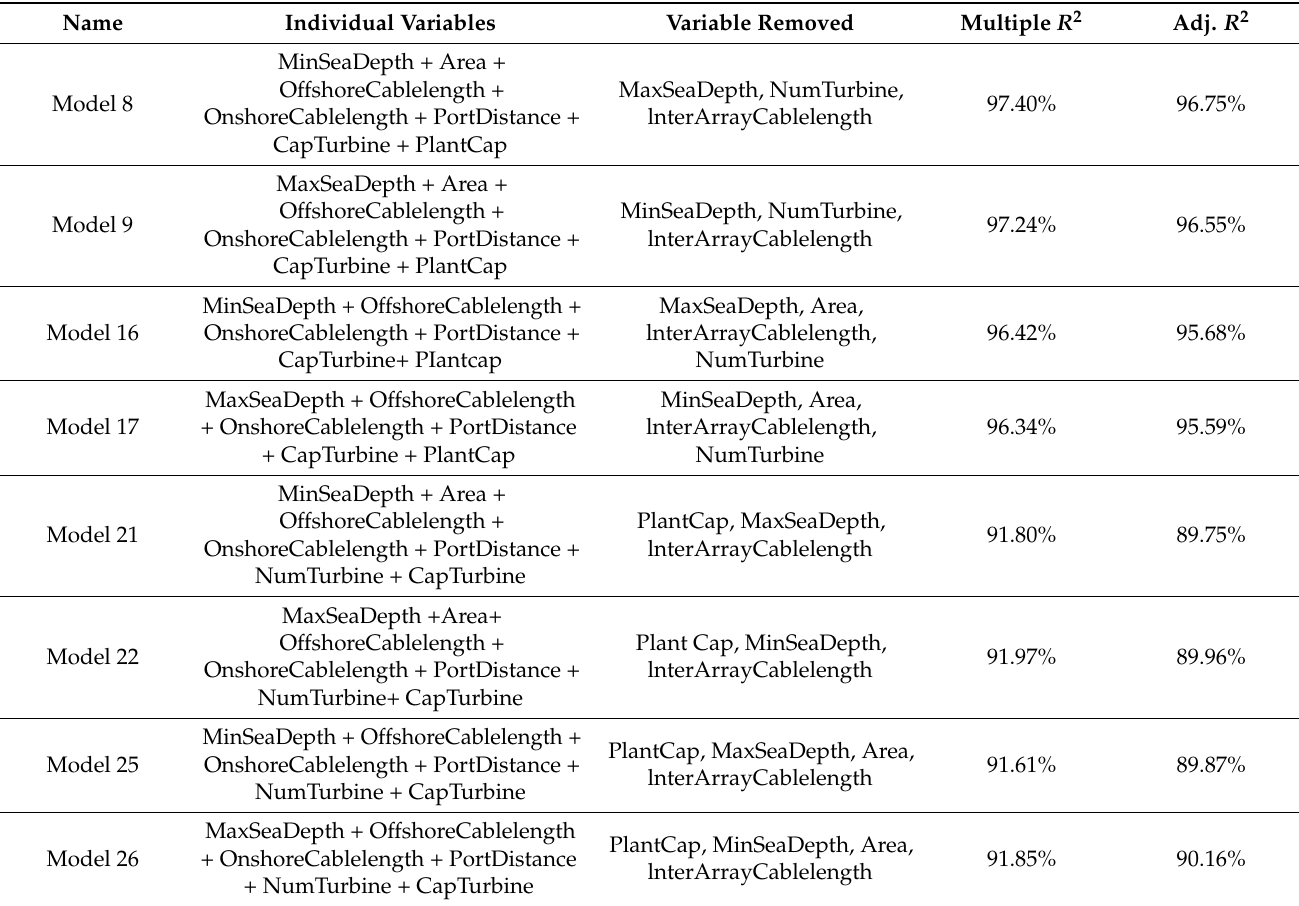
Table 2. Coefficient of determination of the multiple linear regression